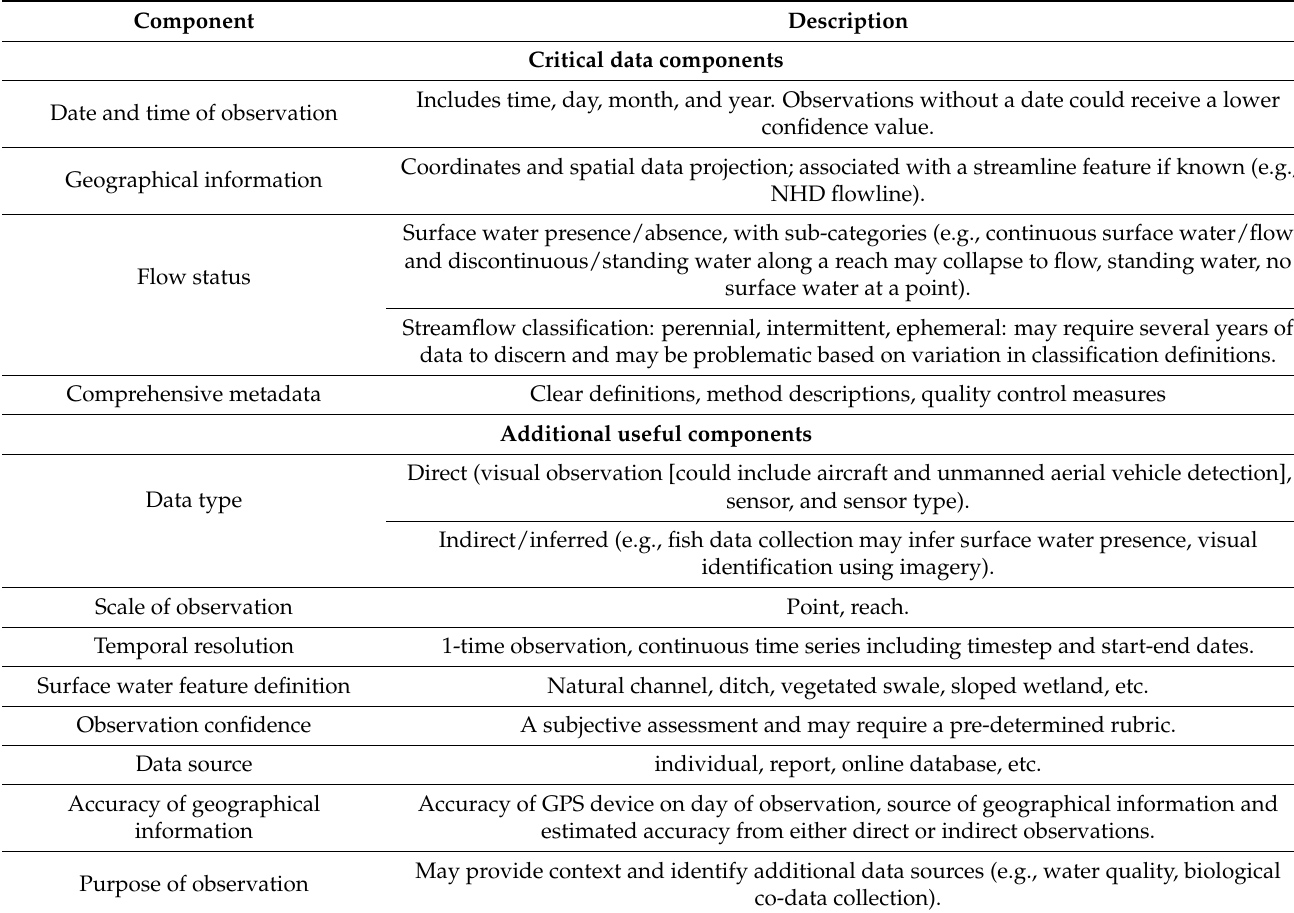
Table 4. Proposed components for a database for streamflow permanence